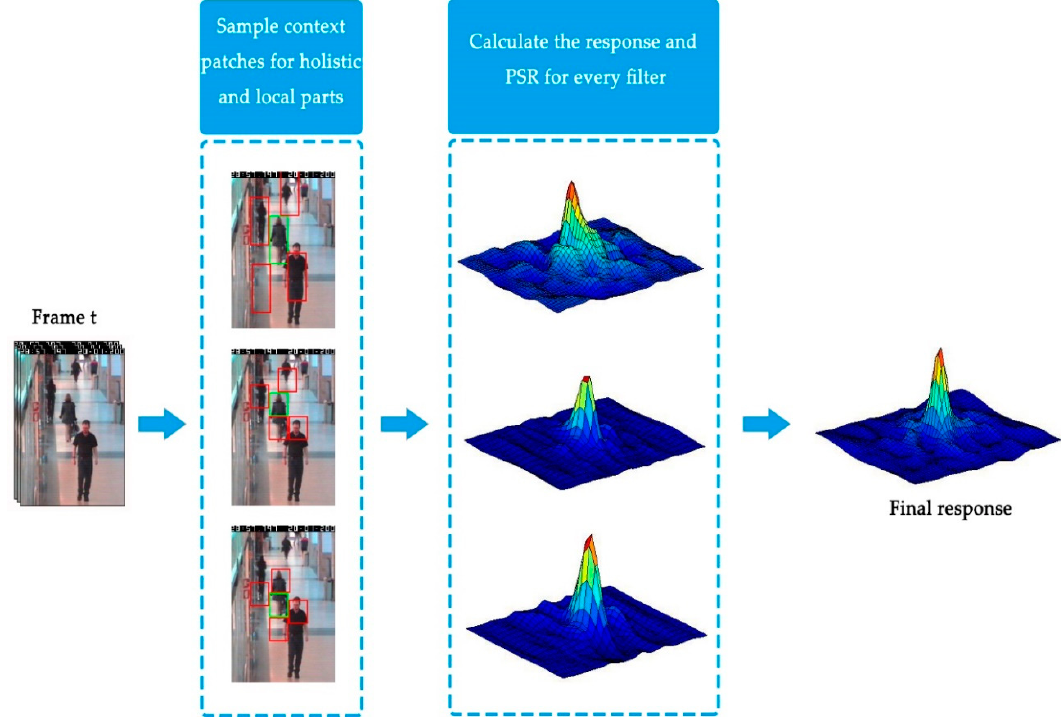
Figure 1. Procedure of the adaptive context-aware and structural correlation filter. For a new frame, sampling optimal context patches for holistic and local parts. Then computing the response and Peak to Sidelobe Ratio for every filter. Finally, combining confidence maps of each parts with adaptive weight to obtain the final confidence map.